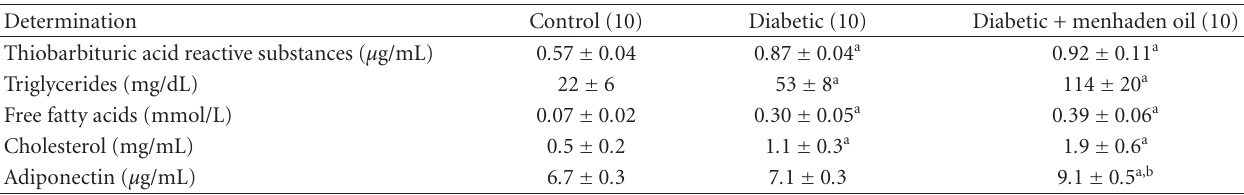
Table 4: E ff ect of partial menhaden oil substitution in the diet of high-fat/streptozotocin diabetic rats on serum thio barbituric acid reactive substances, triglycerides, free fatty acids, cholesterol, and adiponectin. Determination Control (10) Diabetic (10) Diabetic + menhaden oil (10) Thiobarbituric acid reactive substances ( μ g/mL) Triglycerides (mg/dL) Free fatty acids